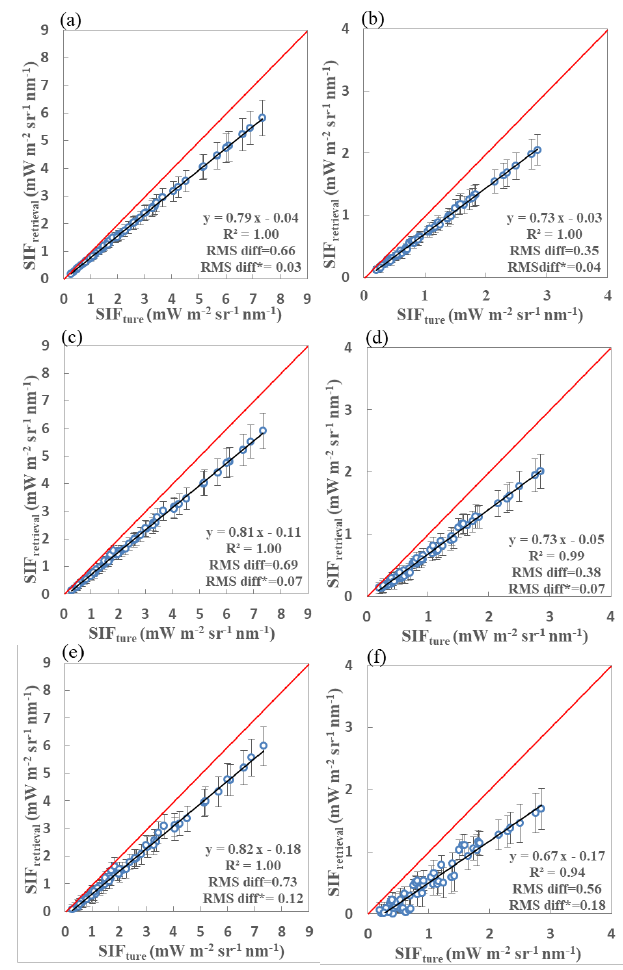
Figure 9. Retrieved vs. true fluorescence using far-red ( a , c , e ) and red ( b , d , f ) fitting windows derived from noise-free simulated data with spectral resolutions of 0.1 nm ( a , b ), 0.3 nm ( c , d ), and 0.5 nm ( e , f ). Standard derivation error bars are also shown as vertical lines for each vegetation canopy type. The true SIF values at each band are averaged over the fitting windows for 60 simulated vegetation canopy conditions. The circles mark the averaged retrieved SIF value for a total of 4608 atmospheric and geometrical